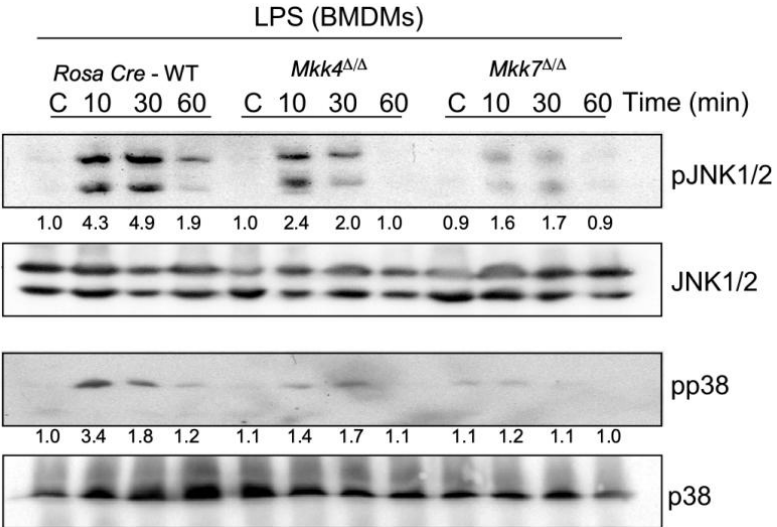
Figure 2. Effect of MKK4 or MKK7-deficiency on the response to LPS. BMDMs isolated from Rosa26-Cre ERT , Rosa26-Cre ERT - Mkk4 -floxed, and Rosa26-Cre ERT - Mkk7 -floxed conditional mice were treated with 4-hydroxytamoxifen for respective gene deletion. 5 days post deletion, BMDMs were treated with or without 100 ng/mL LPS for 10, 30, and 60 min. Protein extracts were examined by immunoblot analysis by probing with antibodies to MAP kinases and phospho-MAP kinases. All relative quantification values of western blots were measured in comparison to control. All the experiments were repeated 3–4 times.